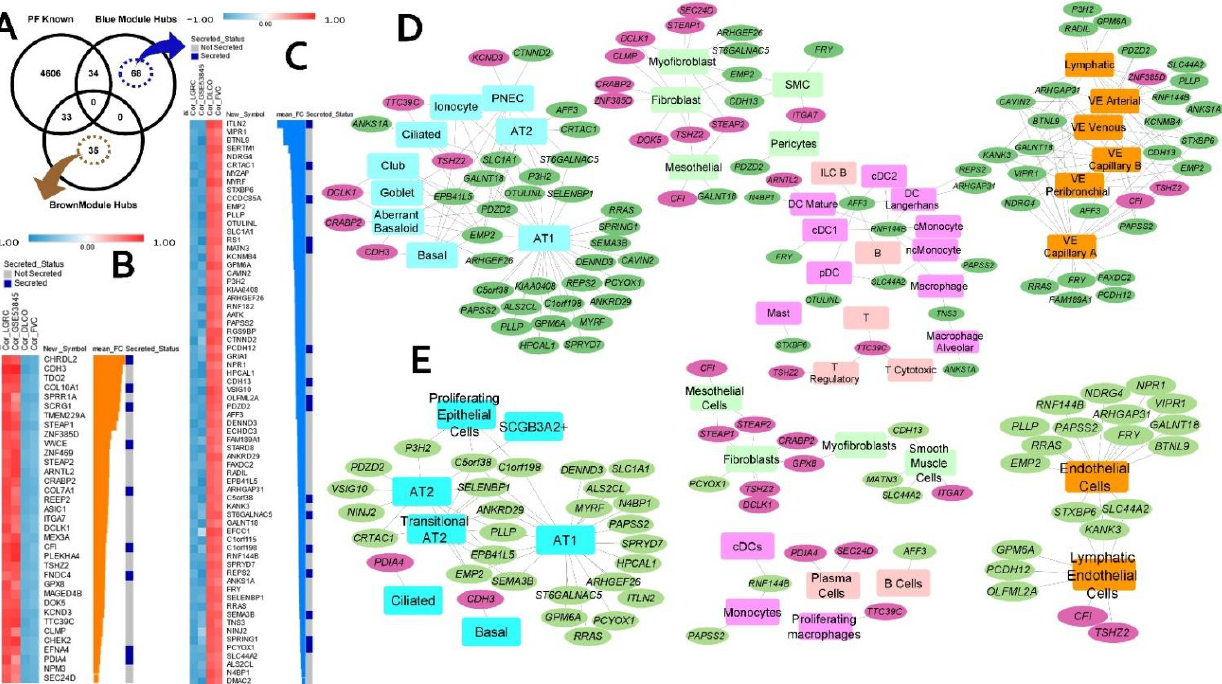
Figure 3. Novel IPF candidate genes and their cell types (based on two IPF scRNA-seq datasets). ( A ) Venn diagram illustrating the overlap between intramodular hubs with a compiled set of known pulmonary fibrosis genes. ( B , C ) Heatmap representation of the IPF and lung function (FVC and DL CO ) correlations of the 35 and 68 novel candidate genes from brown and blue modules, respectively. Also shown in the heatmap are their mean fold change in IPF and whether they encode known secretory proteins. Heatmaps were generated using the Morpheus application. Panels ( D , E ) represent the lung cell associations for the novel candidate genes using two different single-cell data sets from IPF. The pink and green ellipses represent genes from brown (upregulated in IPF) and blue (downregulated in IPF) modules, respectively. The rectangular nodes are different cell types. The cell types are color coded based on their broad cell type, namely, blue for epithelial, light green for mesenchymal, light, and deep pink for lymphoid- and myeloid-immune, respectively, and orange for endothelial cell types. Networks are generated using Cytoscape application.